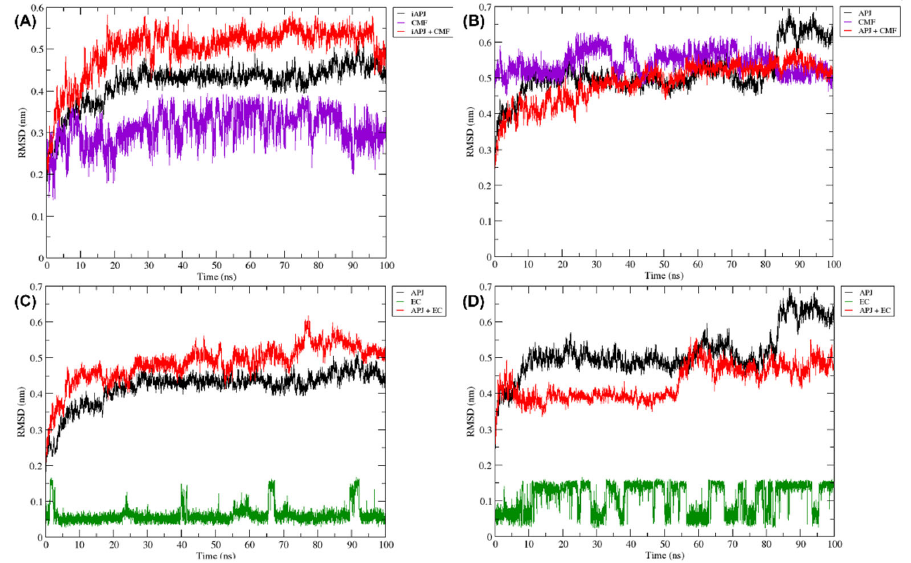
Figure 8. The RMSD plots were obtained from a 100 ns MD simulation. On the ordinate axis, the variation in distance is shown in nanometers and on the abscissa axis, the trajectory time is shown in nanoseconds. In all quadrants, we can see the movement of the APLN receptor alone (black line), the APLN receptor in complex with a ligand (red line), the CMF ligand only in ( A , B ) (purple line), and the EC ligand only in ( C , D ) (green line). iAPLNR = inactive APLNR; aAPLNR = active APLNR; EC = ( ‐ ) ‐ epicatechin; CMF = CMF ‐ 019; APJ = APLNR; black line = receptors MD simulation; red line = receptor in complex with a ligand; green = EC within the receptor; purple line = CMF ‐ 019 within the receptor; ns = nanoseconds; nm = nanometers.